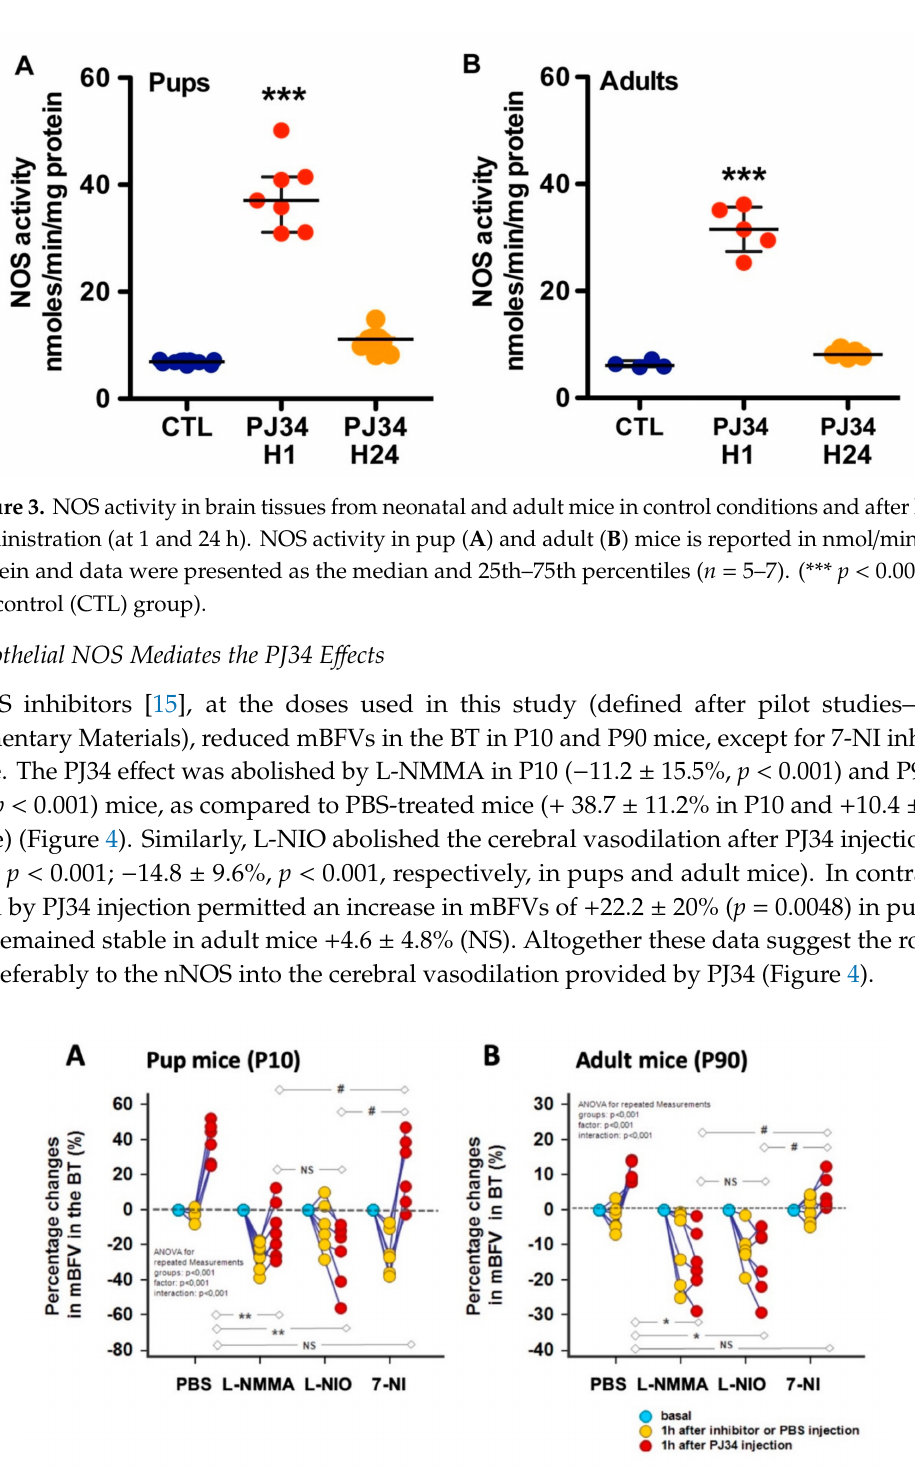
Figure 4. Relative changes in mean blood flow velocities (mBFVs) recorded in the basilar trunk (BT) versus basal states 1 h after PBS or specific or non-specific NOS inhibitors followed 1 h after by PJ34 injection. In P10 ( A ) and P90 ( B ) mice, L-NMMA was responsible of a decrease in mBFVs. L-NMMA as well as L-NIO abolished the increase in mBFVs consecutive to the PJ34 injection as shown in the PBS injected mice. In contrast, 7-NI did not prevent of this increase. Altogether, these finding lead to the mediation of the endothelial more than the neuronal NOS into the dynamic e ff ects of PJ34. (* p < 0.005, ** p < 0.001 PBS + PJ34 vs. NOS inhibitors + PJ34; # p < 0.005 each NOS inhibitors + PJ34 between them, NS : not